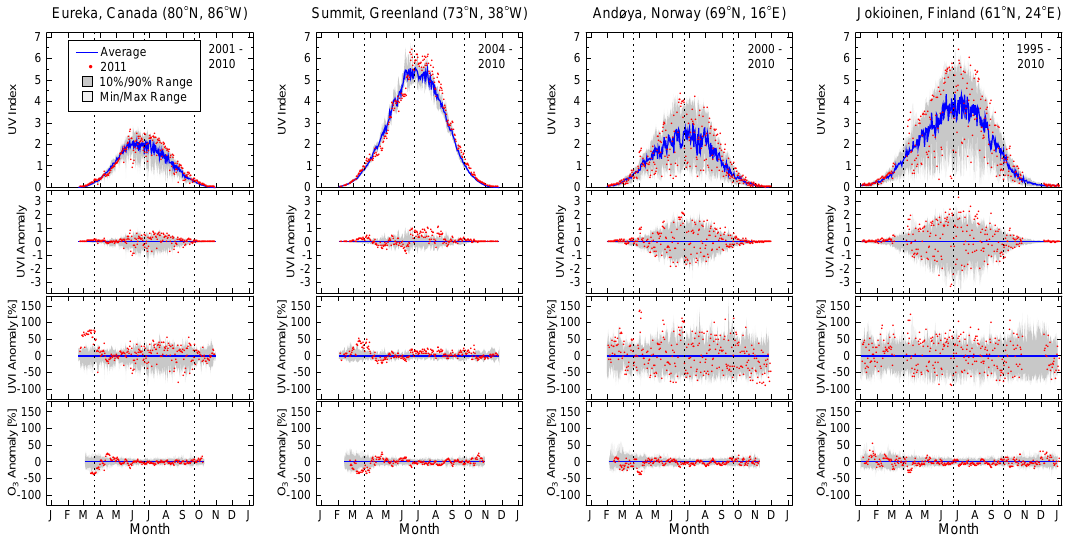
Fig. 3. Seasonal variation of the noontime UV Index at Eureka, Summit, Andøya, and Jokioinen. The top (first) panel for each site compares noontime UVI measurements performed in 2011 (red dots) with the average noontime UVI (blue line), the range between the 10th and 90th percentile (dark shading), and the range of historical minima and maxima (light shading). Average and ranges were calculated from measurements of the periods indicated in the top-right corner of the panel. The second panel shows the 2011 UVI anomaly in absolute terms, calculated as the difference between measurements and the average. The third panel shows the relative UVI anomaly calculated as the percentage departure from the climatological mean. The fourth panel shows a similar anomaly analysis for total ozone derived from satellite measurements. Data from Andøya were subsampled at 15min intervals. Vertical broken lines indicate the times of the vernal equinox, summer solstice, and autumnal equinox,